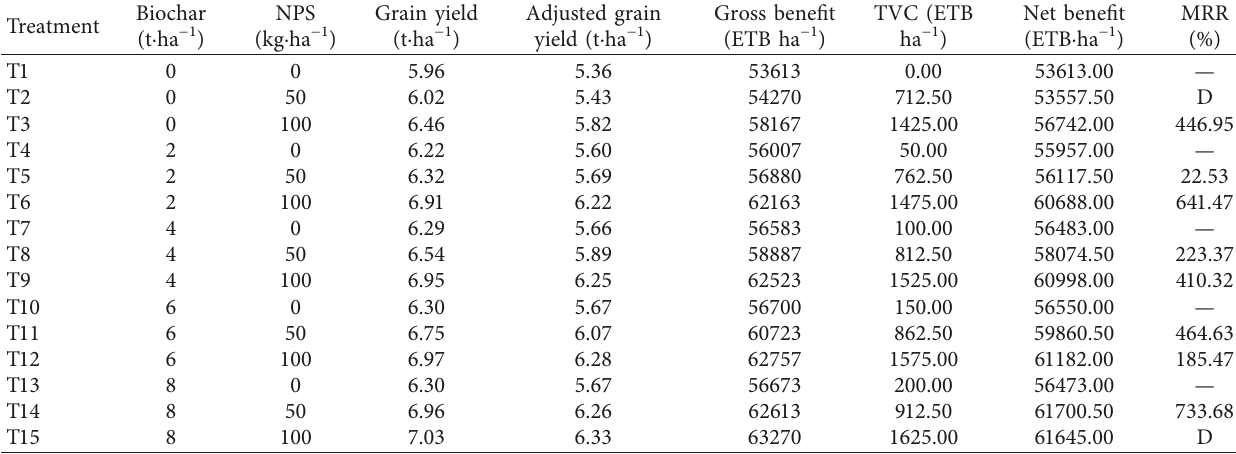
Table 7: Partial budget analysis of maize yield for the determination of economically profitable level of biochar and NPS fertilizer rate Treatment